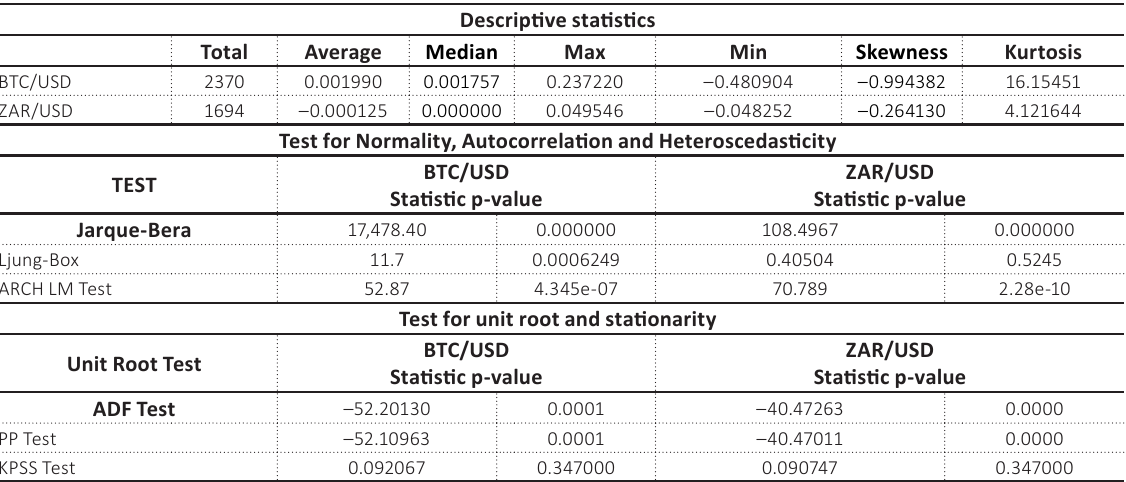
Table 2. Descriptive statistics of exchange rate price